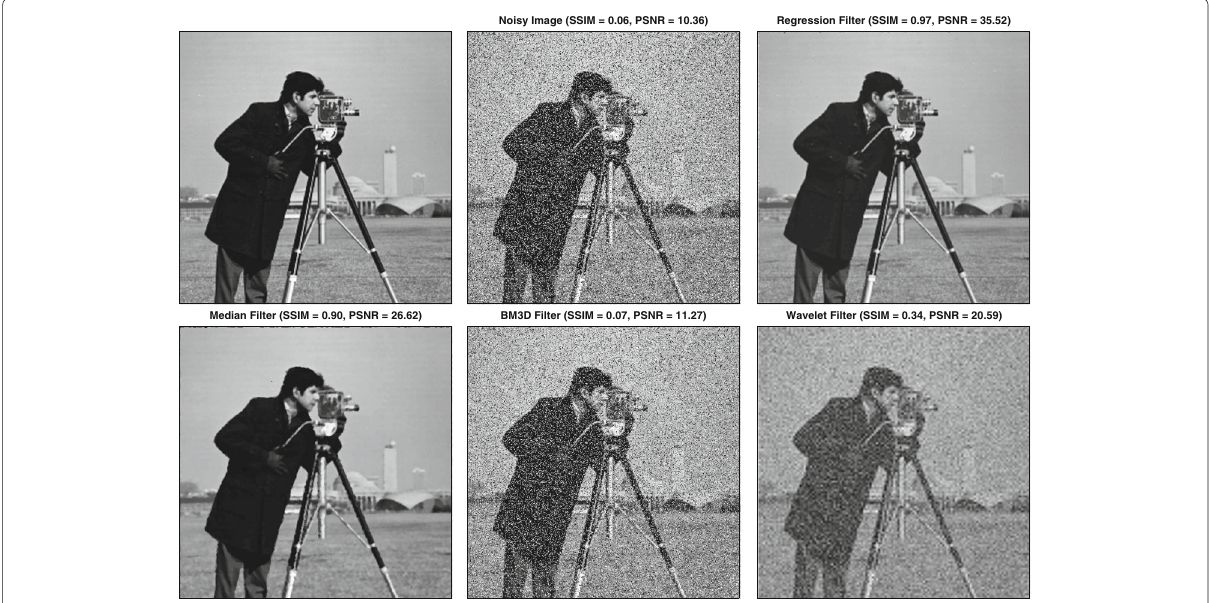
Fig. 2 Added salt & pepper noise with p = 0.3. From left to right: a clean cameraman, b noisy image, c denoised image using our L 2 robust regression filter, d denoised image using median filter, e denoised image using BM3D, and f denoised image using wavelet